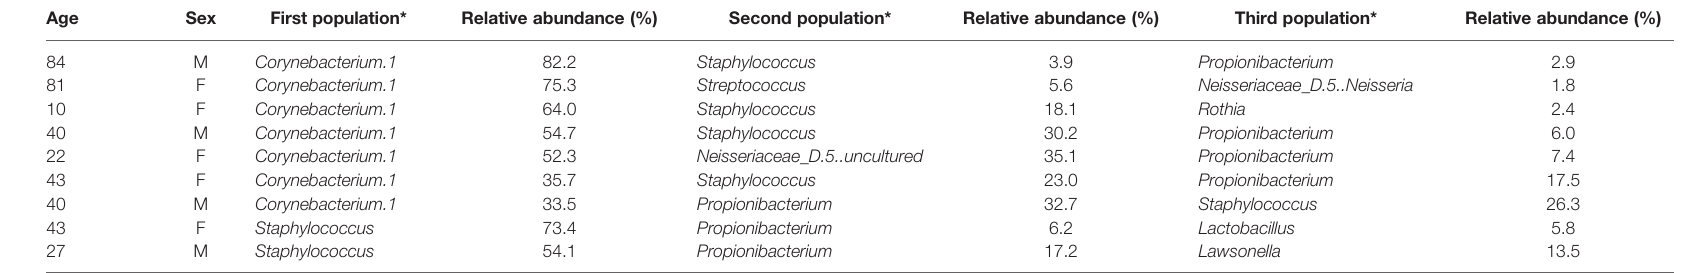
TABLE 1A | Predominant genera in healthy controls. Age